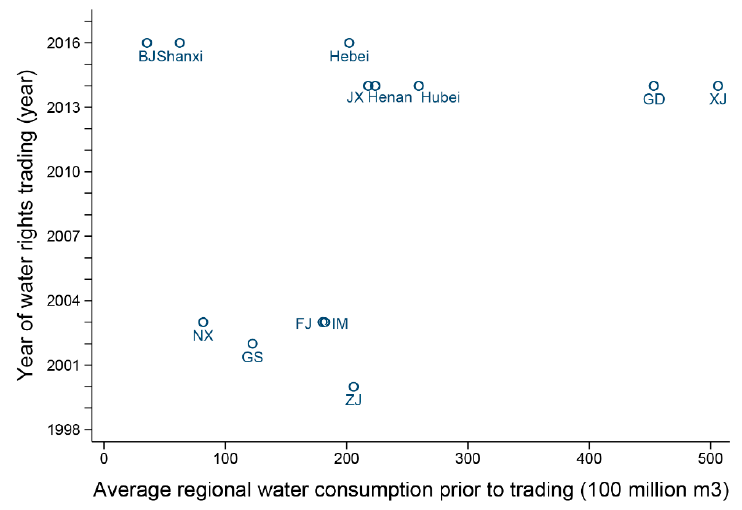
Figure 1. Timing of water rights trading and pre-existing regional water consumption.